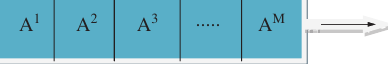
Figure 4: Keys for